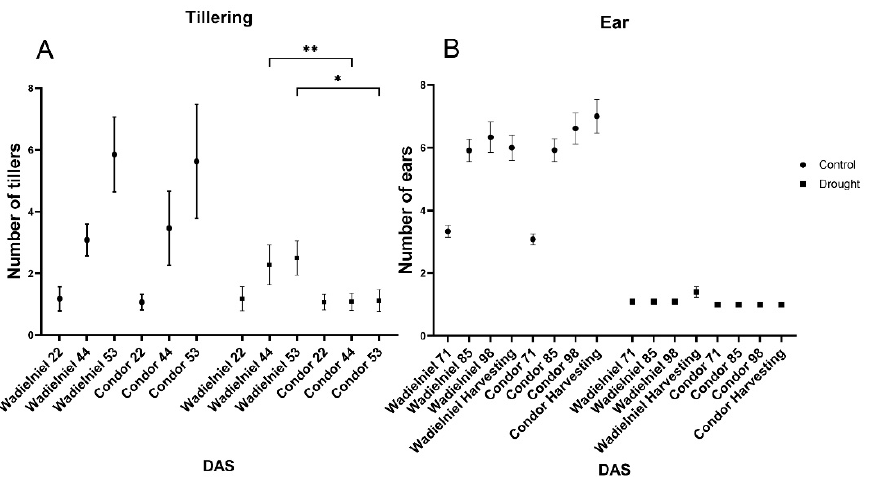
Figure 1. Phenotypical traits in wheat cultivars in response to water deficit stress. ( A ). Number of tillers observed and ( B ) number of ears in both cultivars. Samples were taken in different timepoints DAS 22, 44, and 53 for tillering and DAS 71, 85, 98, and at harvesting day for ear number. Ear number was inferred from visual inspection of images taken by the phenotyping system. Bars show mean ± SD. Statistical significances are determined by a Student t -test between cultivars in the same experimental conditions * p < 0.05, ** p < 0.01.